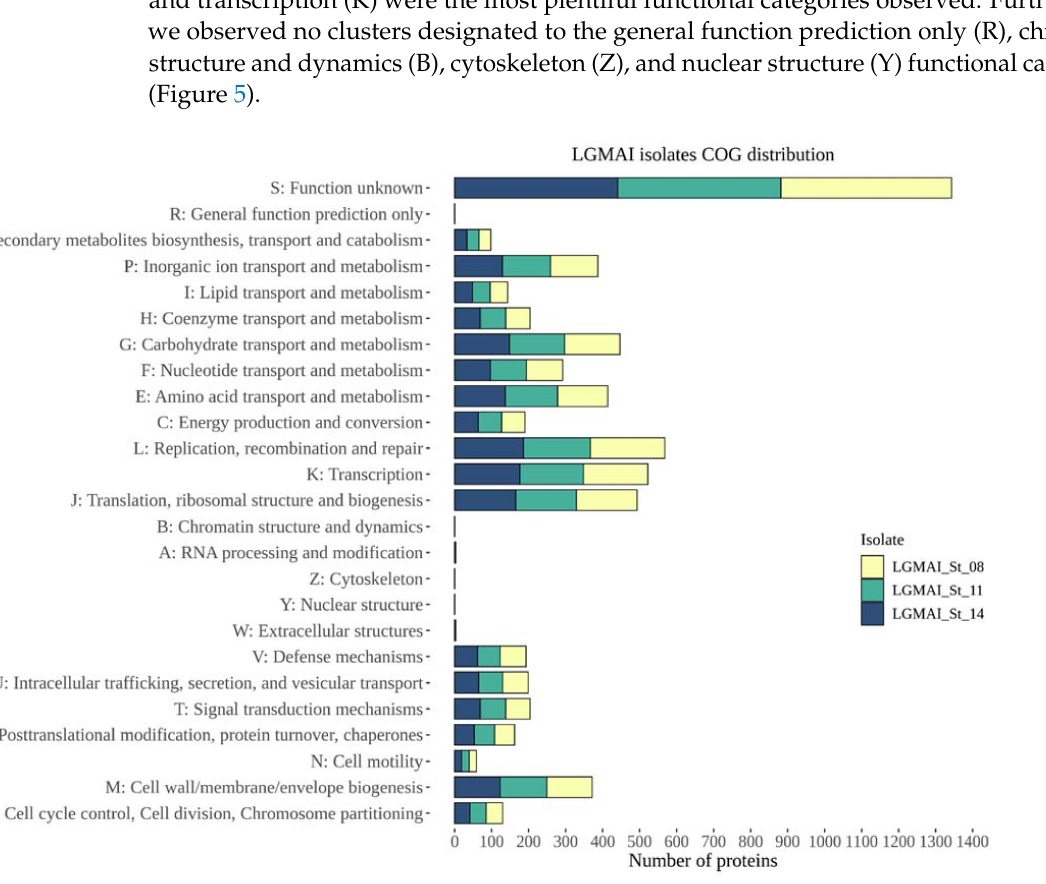
Figure 5. Stacked bar plot displaying the functional annotation of clusters of orthologous groups for the three LGMAI Streptococcus agalactiae strains. The number of proteins is on the x -axis, and COG categories are on the y -axis. Colors represent their respective LGMAI